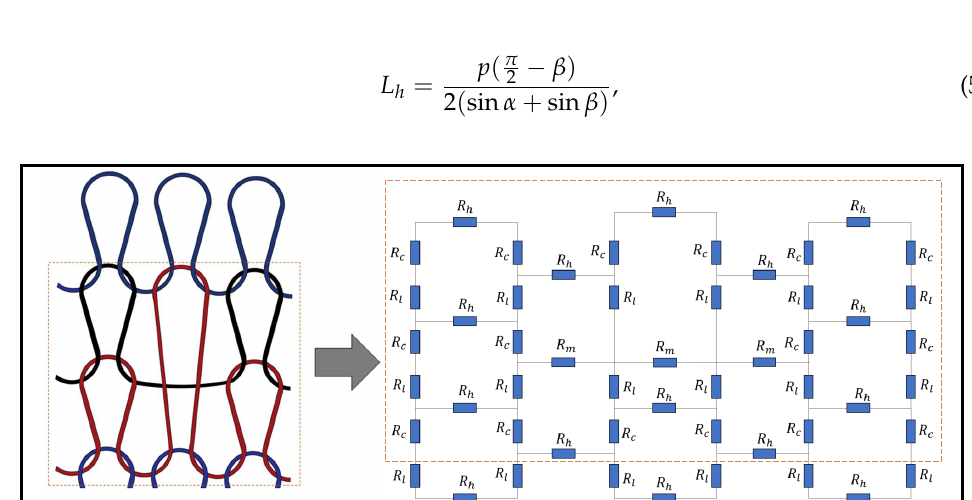
Figure 3. Resistive model of a Miss stitch in a Weft Knit